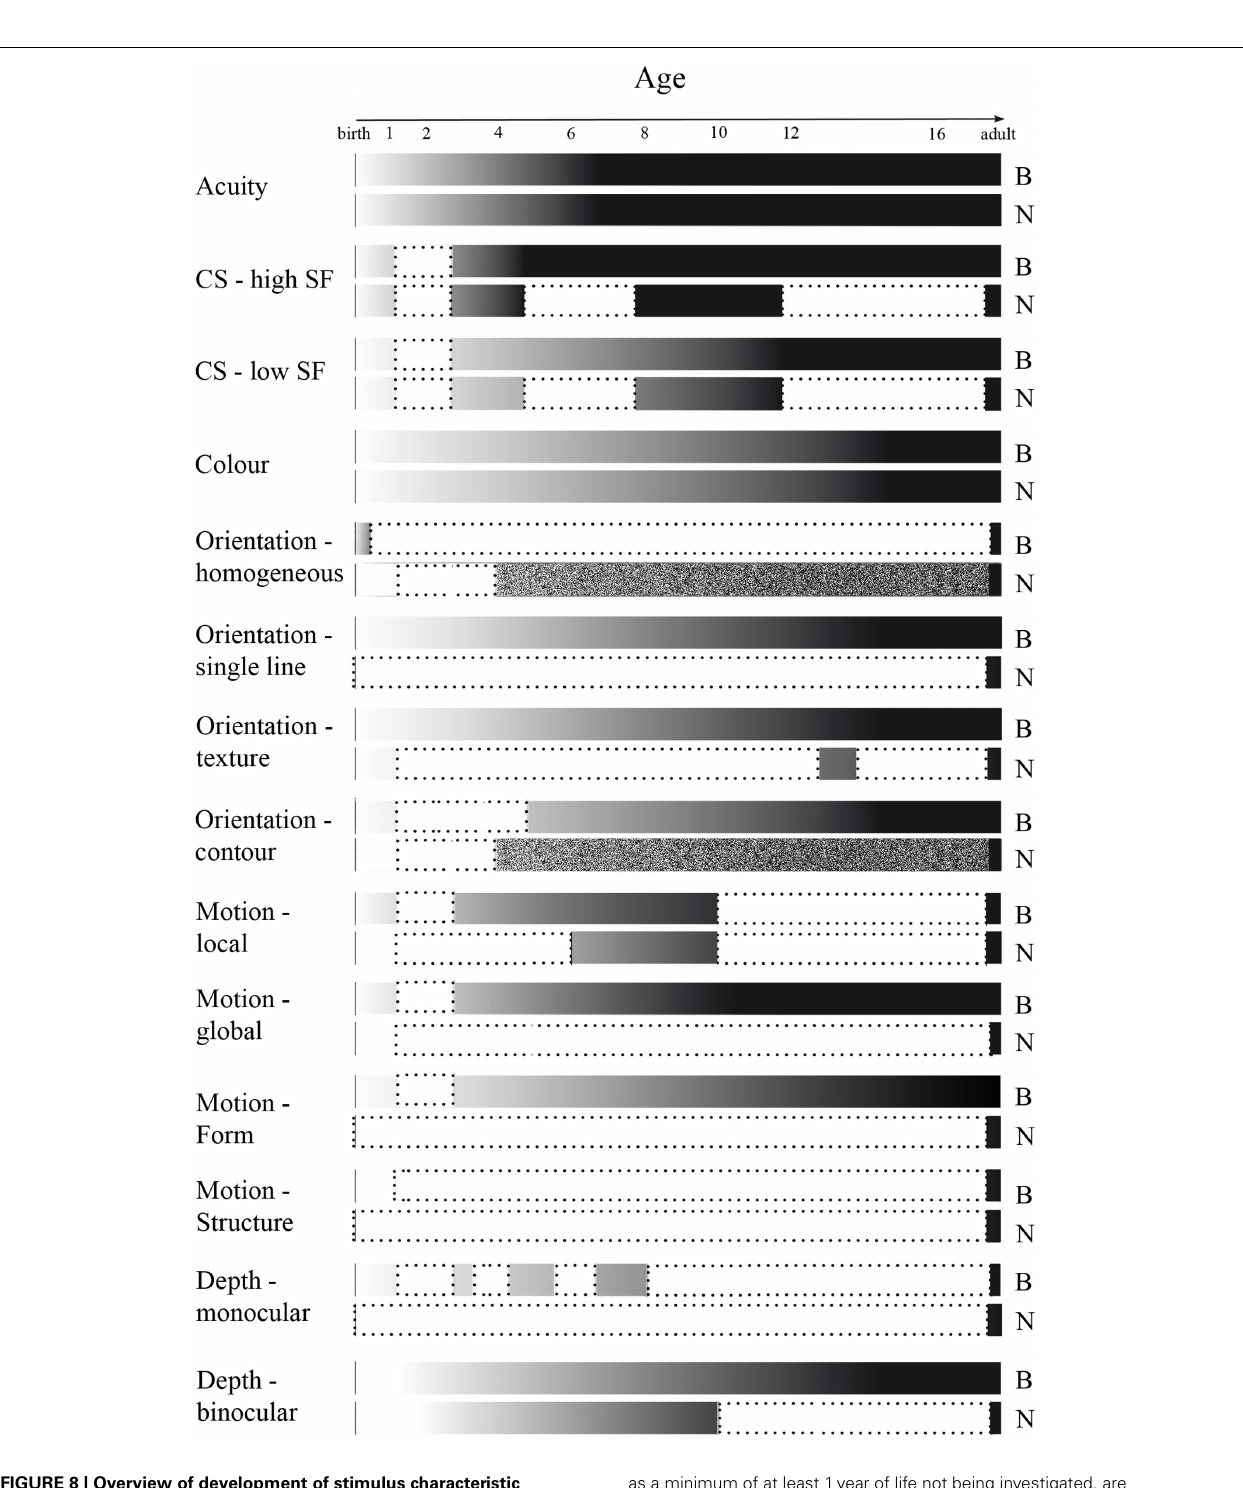
as a minimum of at least 1year of life not being investigated, are depicted in white surrounded by a dotted line. Age ranges investigated but not compared to processing in other age ranges are depicted as